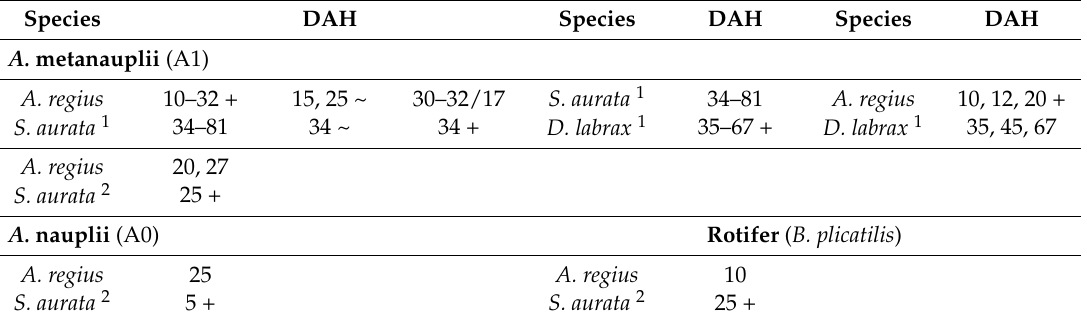
Table 2. Inhibitions and contributions of live foods on protease activities of marine fish larvae *.